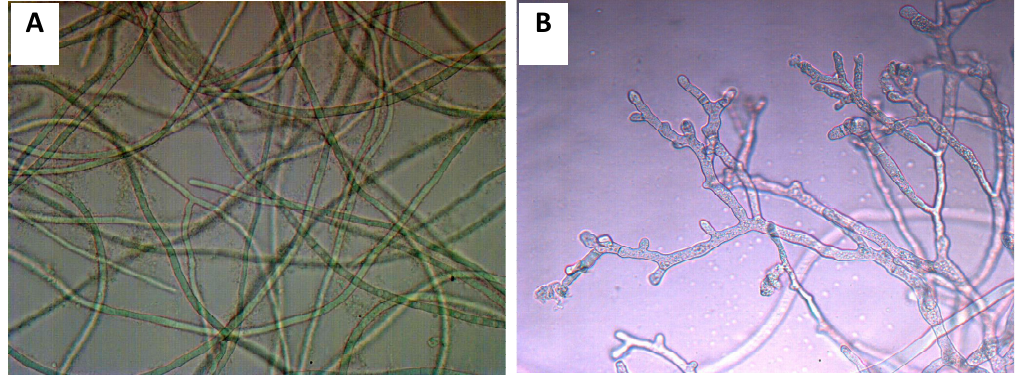
Figure 5. The morphological alteration of B. maydis mycelium treated by total saponin at a concentration of 250 μ g/mL for 24 h observed with optical microscope. ( A ) Healthy mycelium; ( B ) treated mycelium.